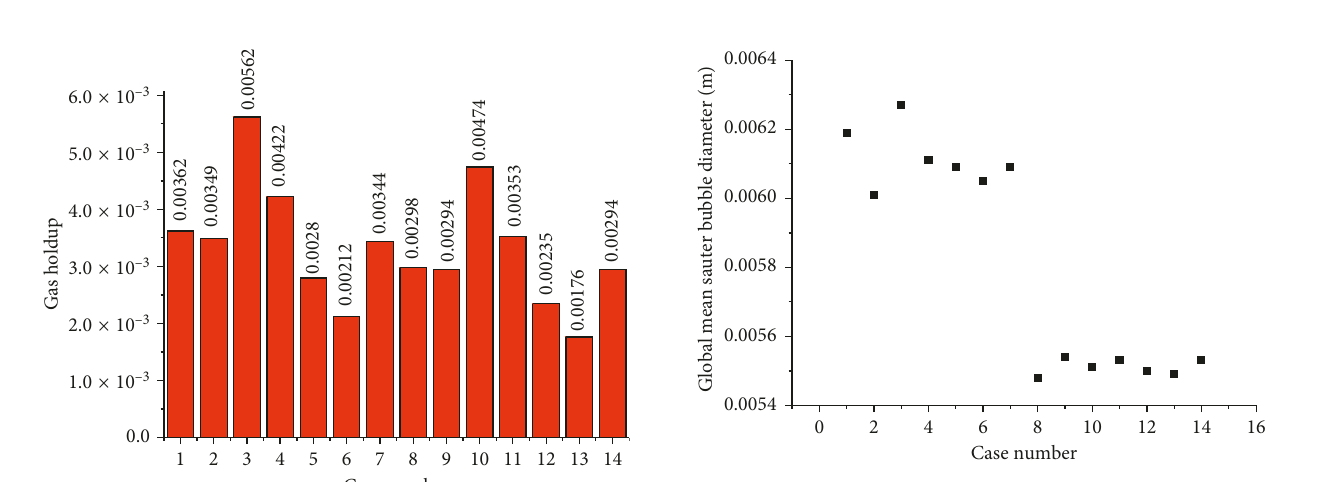
Figure 7: Comparison of volume-average bubble